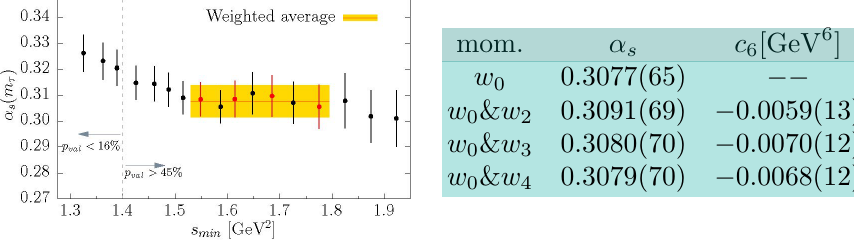
Figure 2. Left panel: Single-weight w 0 = 1 fit results for α s ( m τ ) vs. s min . P-values are < 16% to the left of the dashed vertical line and > 45% to the right. Right panel: results for α s ( m τ ) and the D = 6 condensate, c 6 , from fits using the weights shown in the first